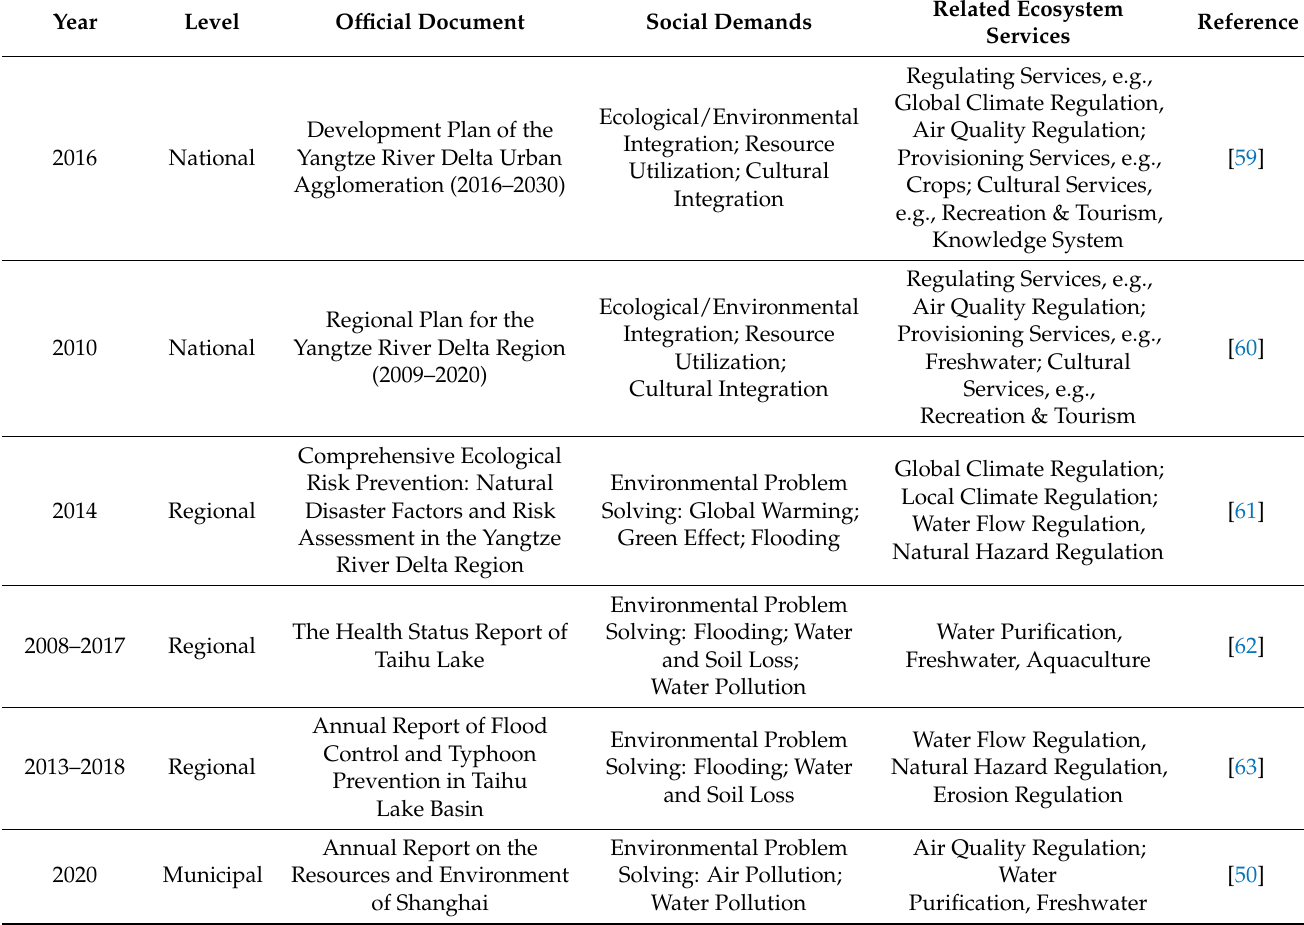
Table 2. Key Government Documents/Environmental Reports and Related Ecosystem Services (After